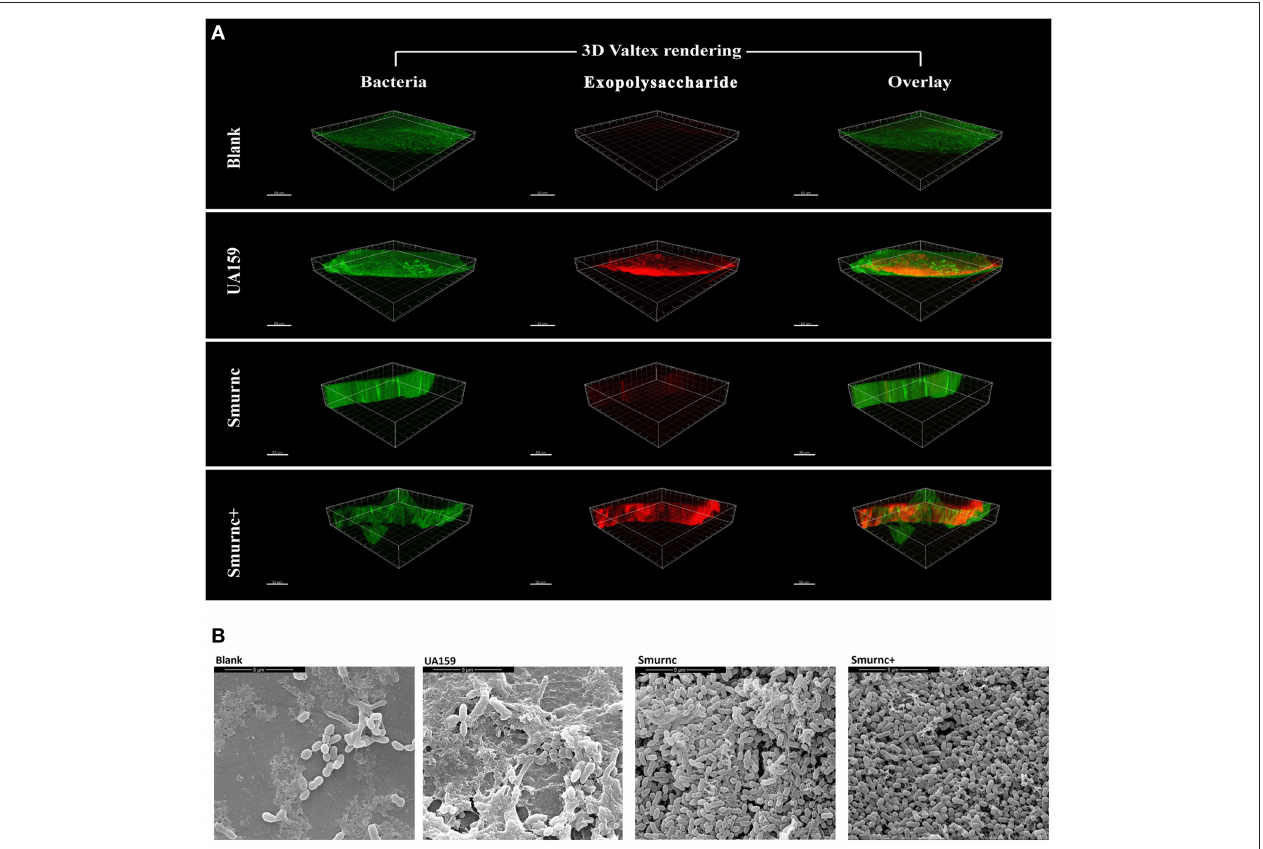
FIGURE 2 | The influences of rnc gene on S. mutans cariogenicity in the SPF rat model. (A) Representative three-dimensional images of biofilms that formed on occlusal plane of rat mandibular molars in four different groups by CLSM. Images were taken at 63 × magnification. (B) SEM observation of the architecture of biofilms that formed on occlusal plane of rat mandibular molars. Images were taken at 20,000 × magnification.